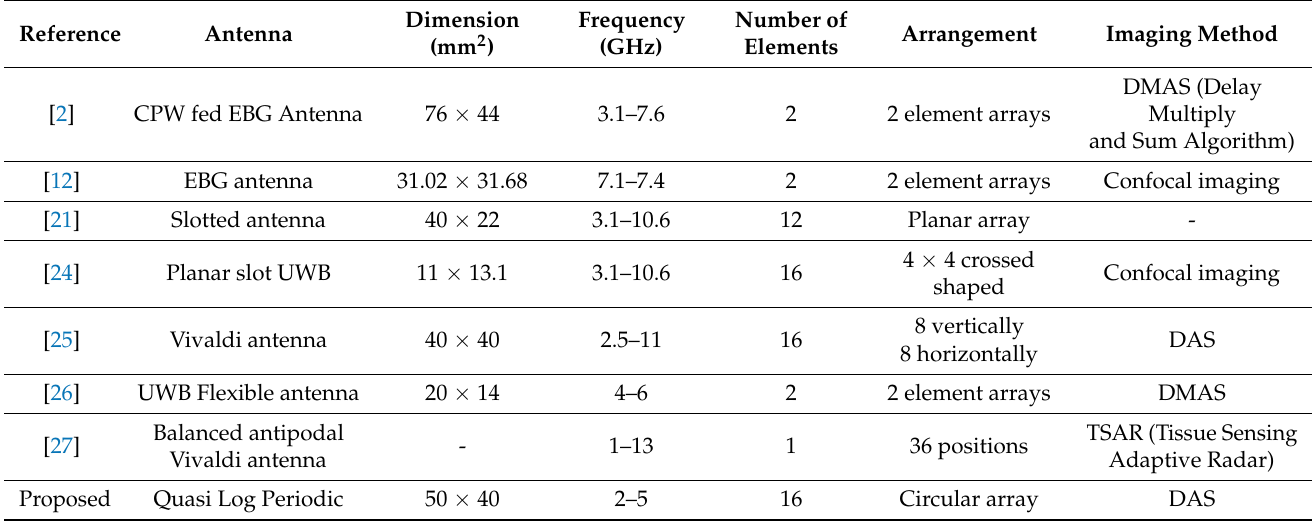
Table 1. Comparison of different ultra-wideband (UWB) microwave imaging system with the proposed